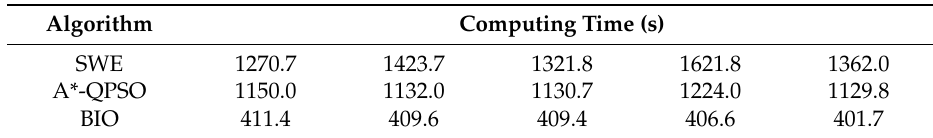
Table 2. Comparison of computing time of SWE, A*- quantum-behaved particle swarm optimization (QPSO) and